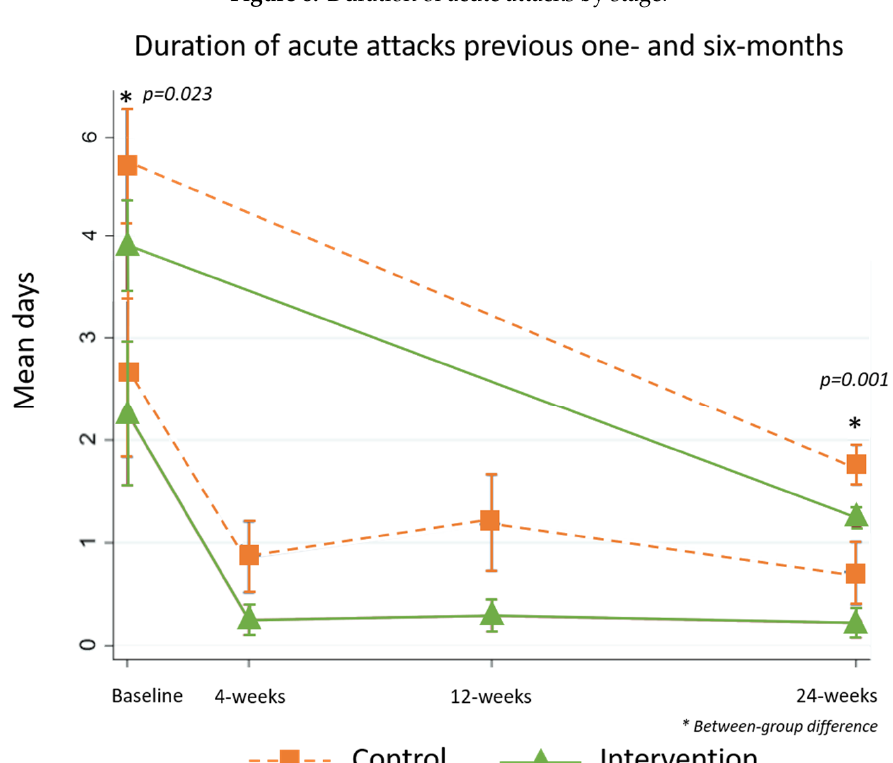
Figure 9. Duration of acute attacks by group.